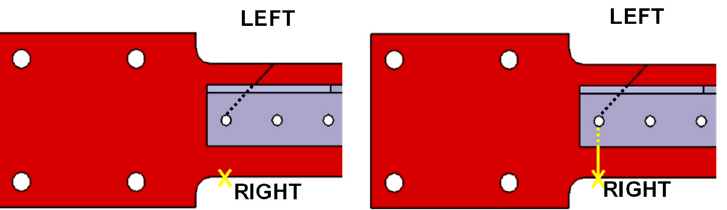
Figure 12. Crack growing from the opposite side of the 45 ◦ cracked sample. The yellow x indicates the start point of the crack propagation. The yellow line represents the crack path.